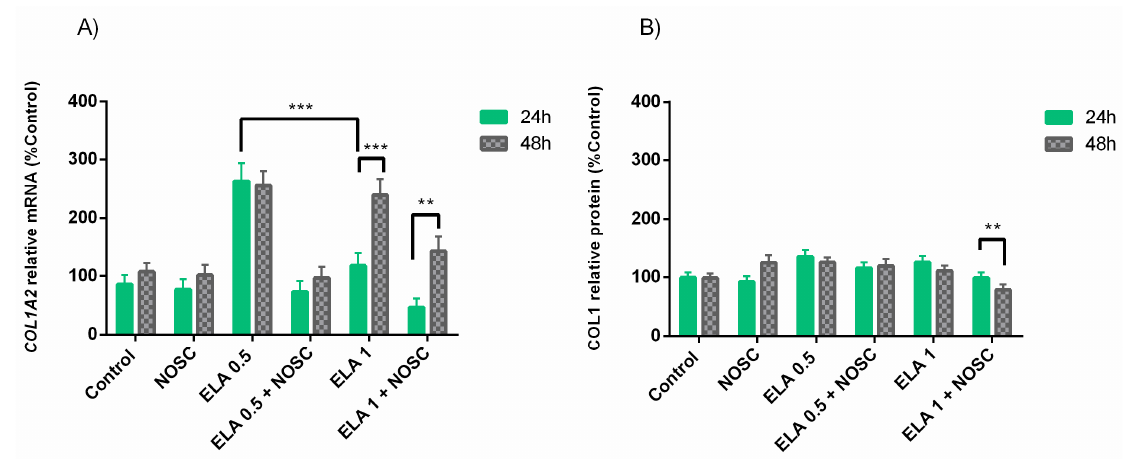
Figure 6. Effect of elastase (ELA; 0.5 or 1 µg/mL), noscapine (NOSC; 45 µg/mL), or ELA (0.5 or 1 µg/mL) + NOSC (45 µg/mL) treatments on relative collagen type I alpha 2 chain ( COL1A2 ) mRNA transcription ( A ) and collagen type I (COL1) protein relative abundance ( B ) in equine endometrial explants treated for 24 or 48 h, regardless of estrous cycle phase. Results are shown as least square means ± SEM and considered significant at p < 0.05. Asterisks above connecting lines indicate significant differences of the same treatment between time of treatment (** p < 0.01; *** p < 0.001).